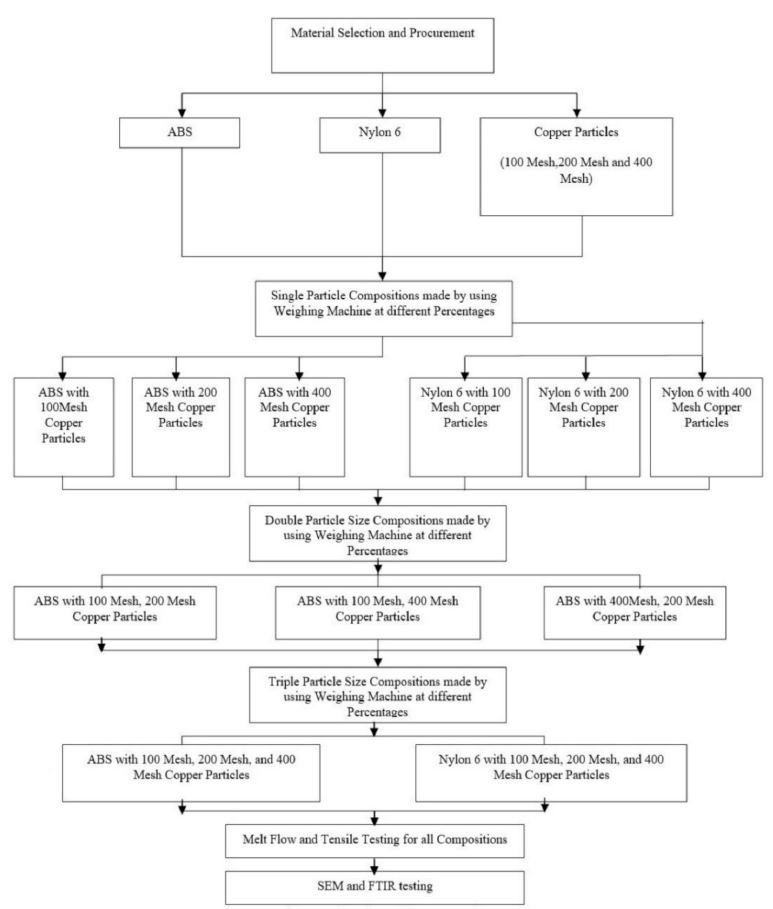
Figure 2. Flow chart of present